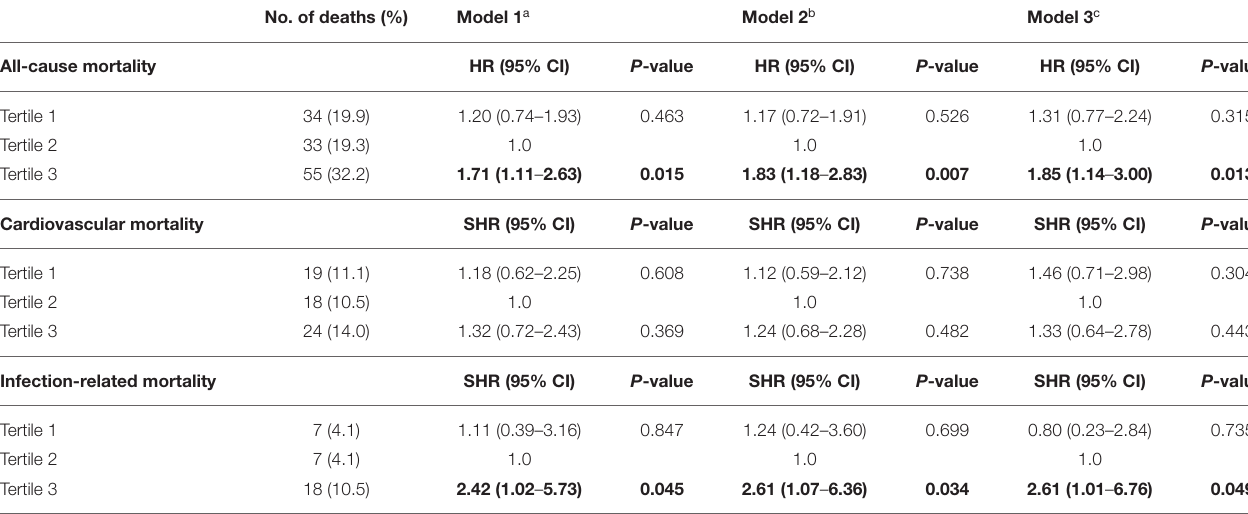
TABLE 3 | Associations of tertiles of serum hepcidin-25 with all-cause, cardiovascular and infection-related mortality. No. of deaths (%) Model 1 a Model 2 b Model 3